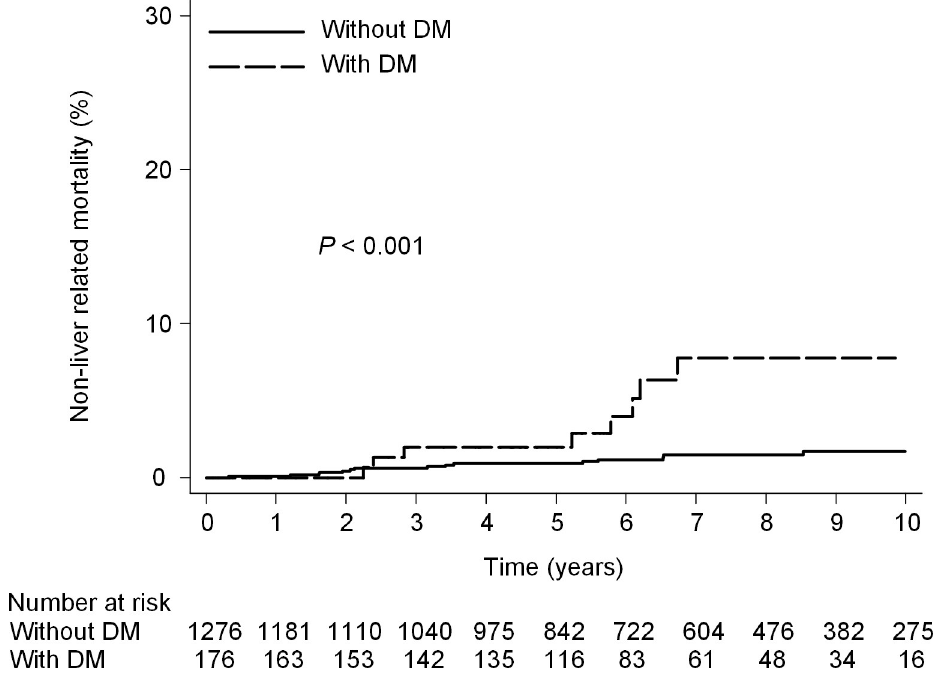
Fig 3. Non-liver-related mortality according to DM. (10- year mortality rate, 1.7% vs 7.7%; HR, 4.8; 95% CI, 2.1– 11.0; P < 0.001).